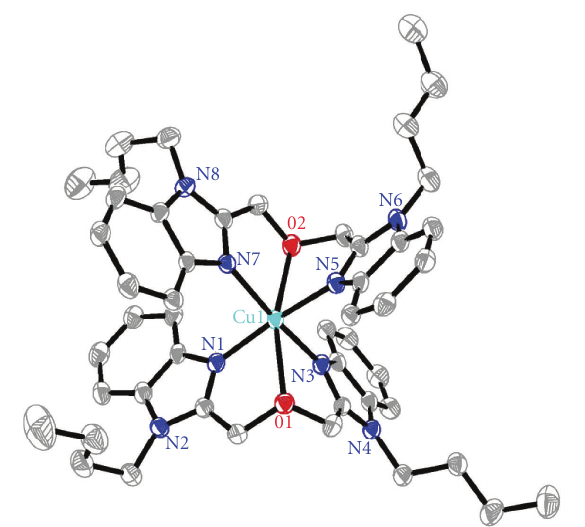
Figure 2: Molecular structure of the [Cu(buobb) 2 ] 2+ cation with displacement ellipsoids drawn at the 30% probability level; H atoms, trinitrophenol anions and DMF are omitted for